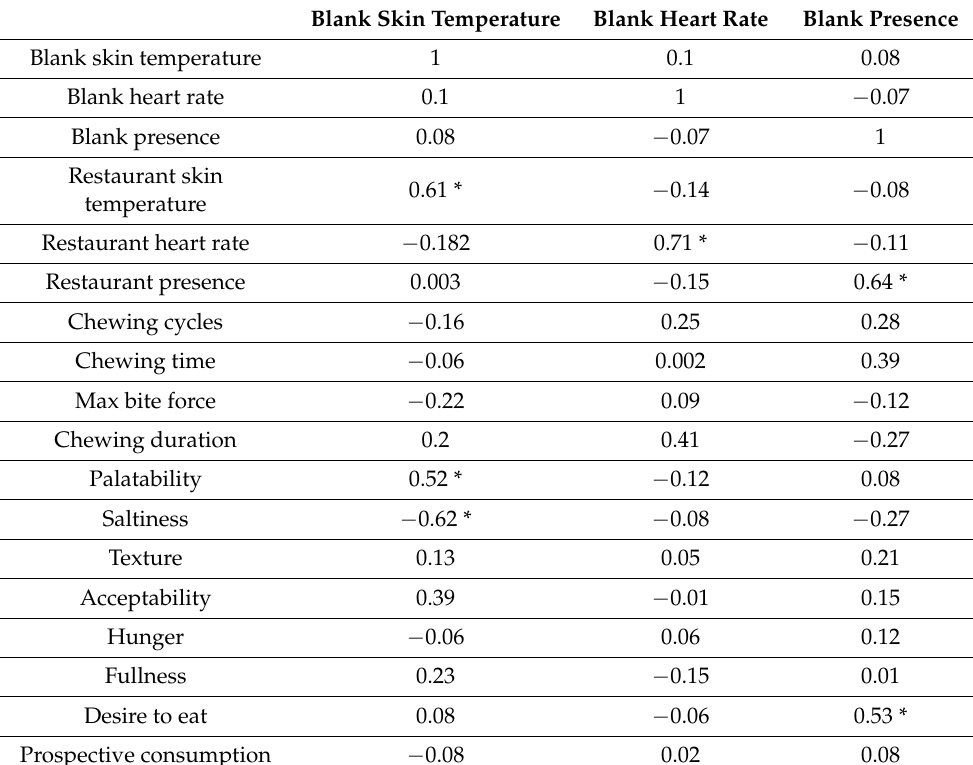
Table 3. Correlation coefficients between markers of presence and masticatory parameters in the blank scene. * p <